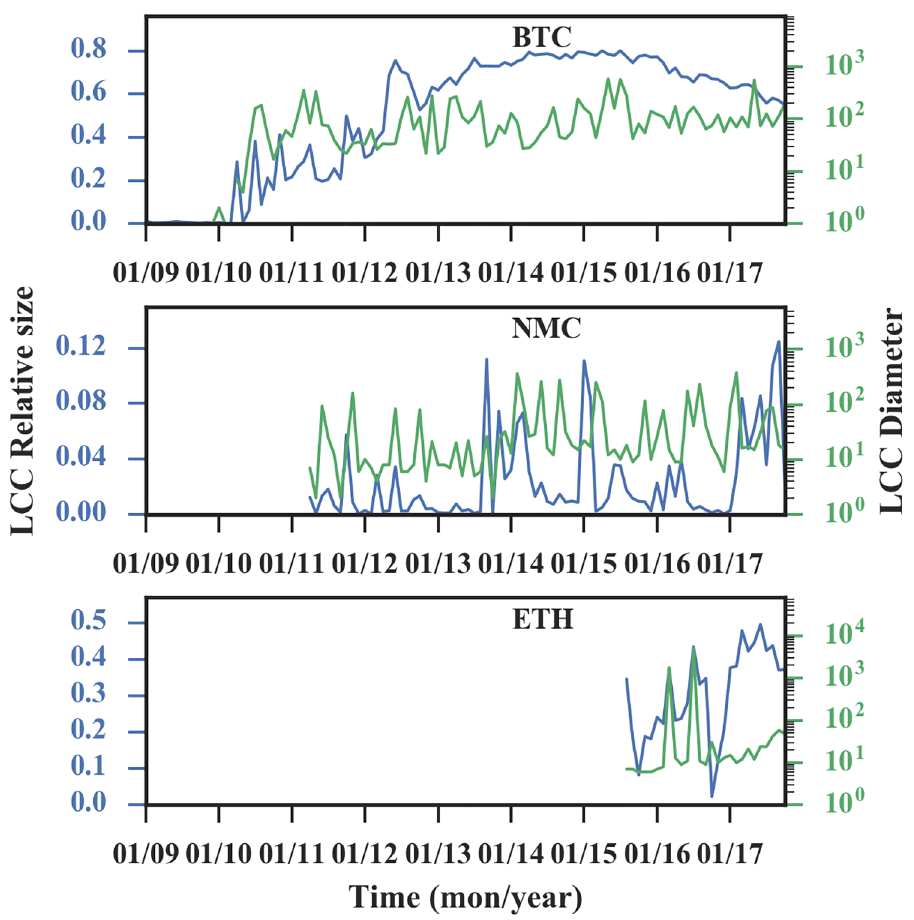
Fig 10. The properties of the LCC. The relative size (blue line) is the proportion of LCC nodes in all nodes, and the diameter (green line) reflects the connectivity of the LCC. Later stage, the relative sizes of the three networks are 60%, 40% and 5% respectively, and the diameter of BTC is 100, while the other two are in fluctuations.